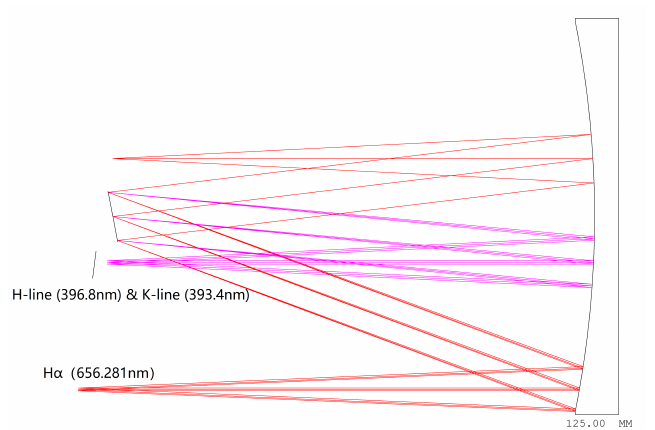
Figure 3. Traditonal method to design a spectrometer with H α line, H-line, and K-line of ionized